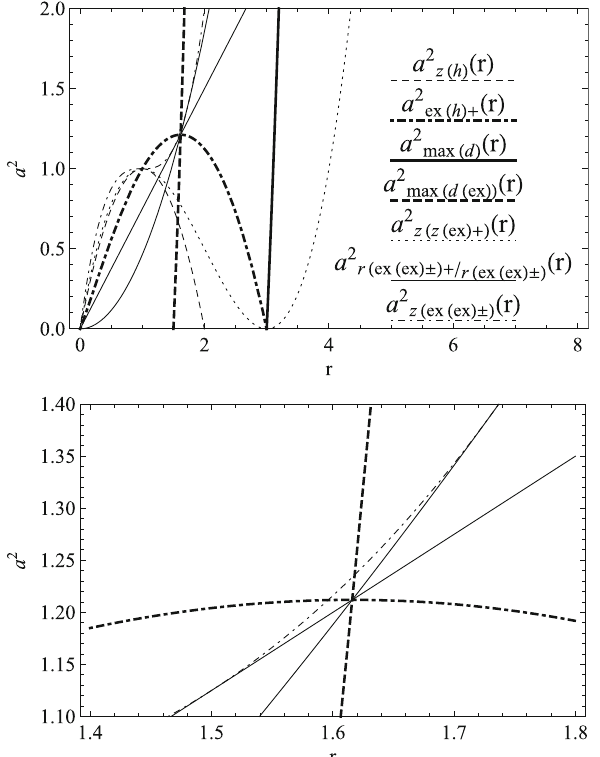
Fig. 5 Characteristic functions a 2 ( r ) determining the behavior of the functions y ( r ; a 2